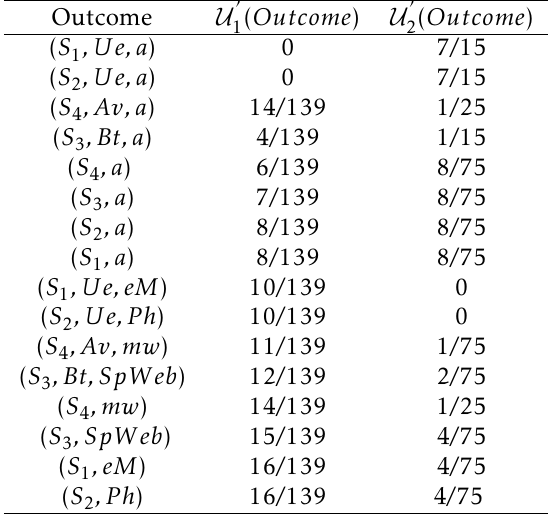
Table 4. Probability weights associated to each